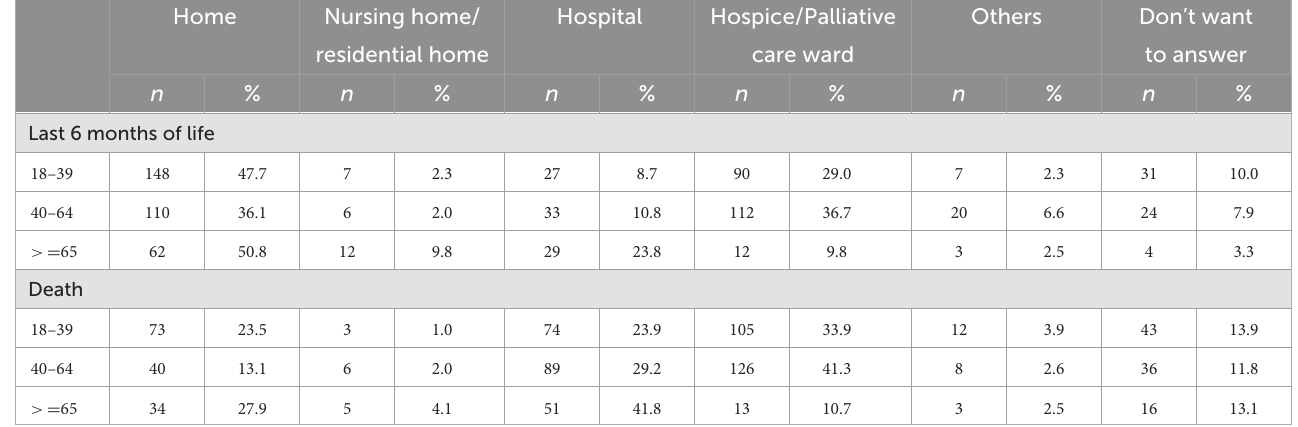
TABLE 3 Respondents’ preferred place of end-of-life care and death by age groups ( n = 737). Home Nursing